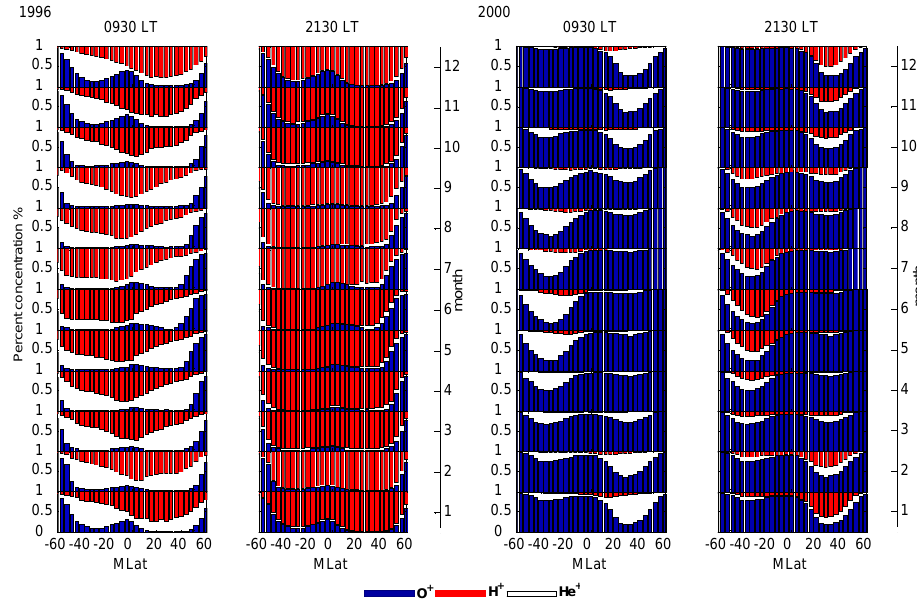
Fig. 5. Percent ion composition of the O + , H + , and He + at 09:30 LT and 21:30 LT for the solar minimum 1996 and maximum Figure 5 . Percent ion composition of the O + , H + , and He + at 0930 LT and 2130 LT for the solar minimum 1996 and maximum 2000.